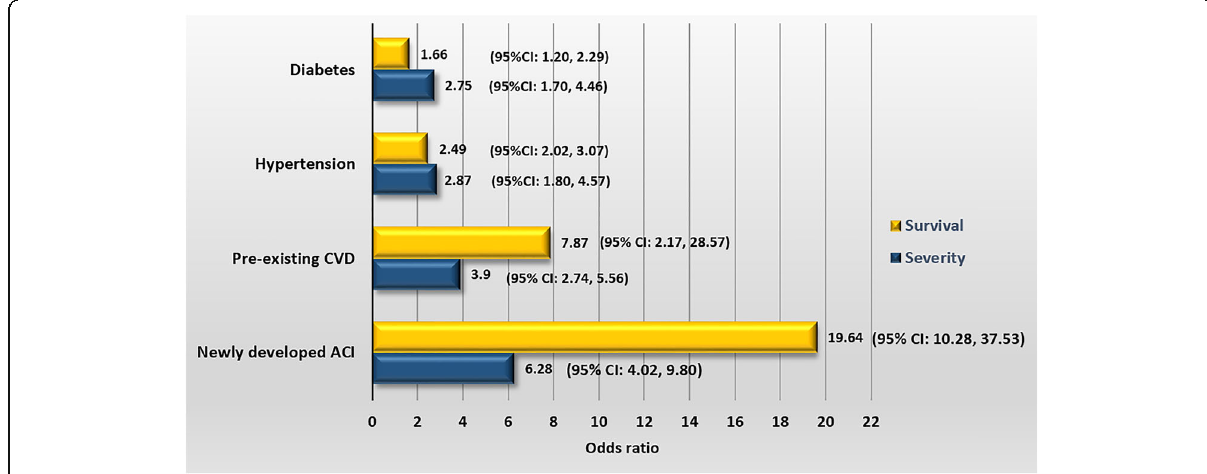
Fig. 3 The odds ratio for death and developing severe forms of COVID-19 infection according to the newly developed acute cardiac injury, hypertension, diabetes mellitus, and pre-existing cardiovascular diseases ( ACI acute cardiac injury, CVD cardiovascular disease, CI confidence